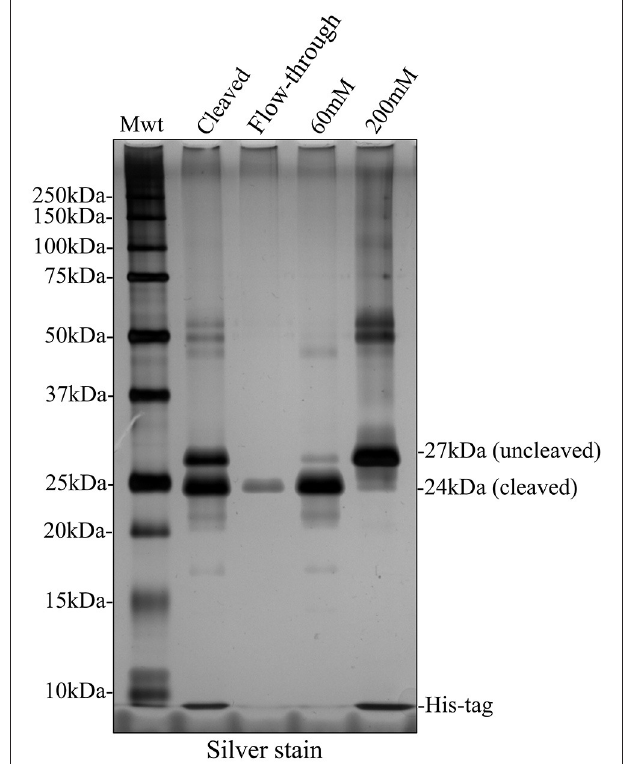
FIGURE 6 | Silver stained SDS PAGE showing second round of nickel column purification to separate cleaved and uncleaved recombinant amelogenin. The bulk of cleaved recombinant amelogenin was eluted by 60 mM imidazole together with lower molecular weight contaminants and some uncleaved recombinant. The uncleaved amelogenin was eluted after increasing the imidazole concentration to 200